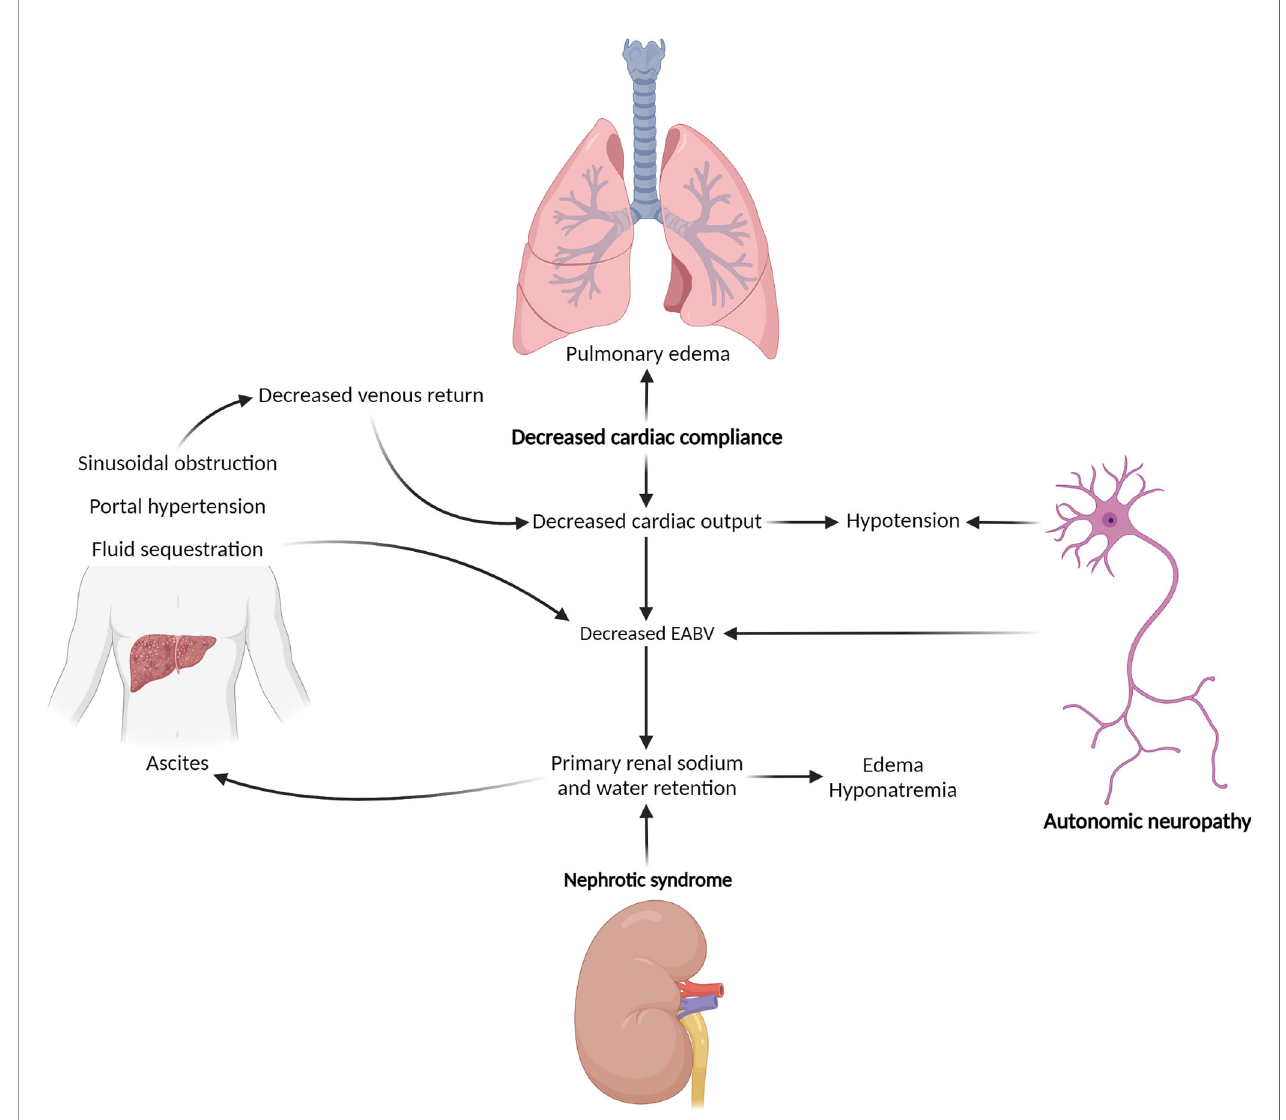
FIGURE 1 | Hemodynamic effects of end-organ injury related to AL amyloidosis. Management of hypotension and third-spacing of fl uid in the setting of AL amyloidosis is complicated by pathophysiologic feedback loops, by which injuries to different organ systems compound one another. Bold type indicates primary effects. EABV, effective arterial blood volume. (Created with